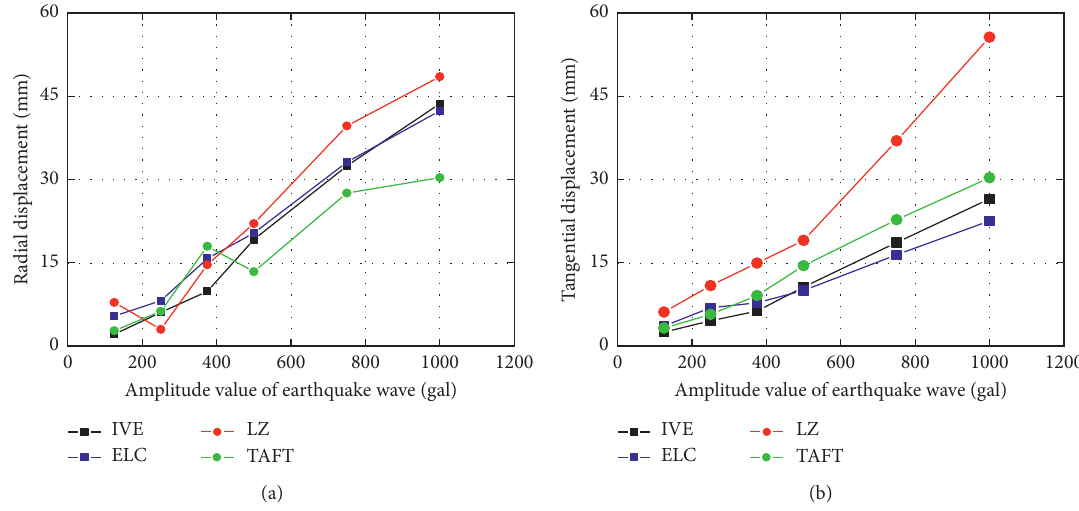
Figure 6: The relationship between displacement response and acceleration of pier 3#. (a) Radial. (b)